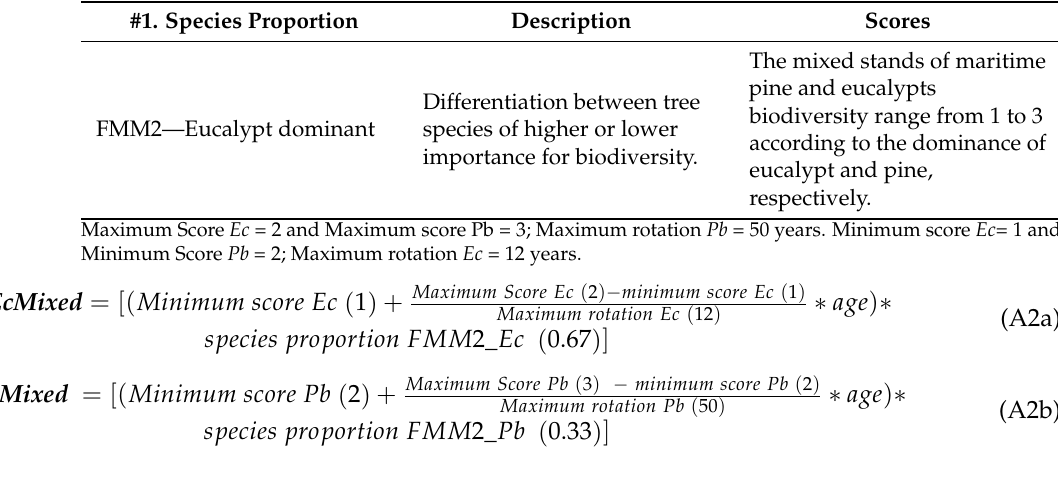
Table 3. Species proportion, description, minimum and maximum values used to define the FMM3 biodiversity score. #1. Species Proportion Description Scores Differentiation between tree Chestnut is associated to a FMM3—Chestnut species of higher or lower biodiversity maximum partial importance for biodiversity. score = 4 Maximum score Ct = 4, Minimum score Ct = 3; Maximum rotation =